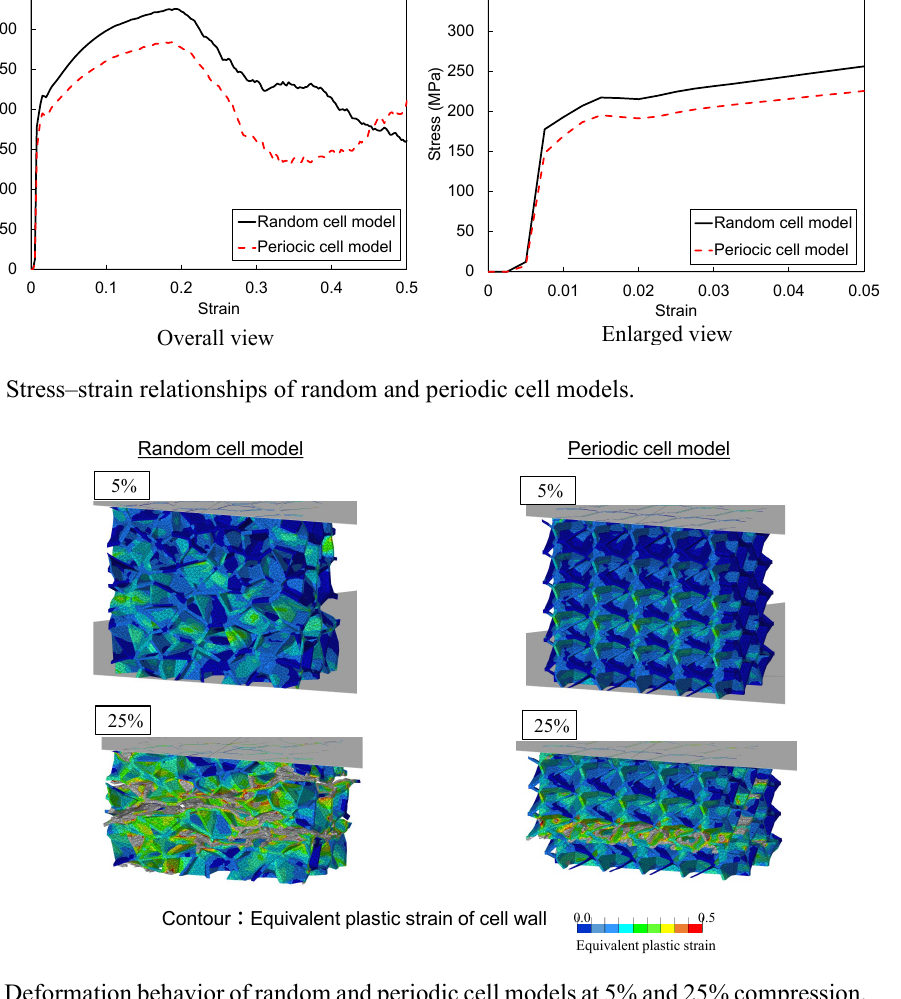
Fig.5. Deformation behavior of random and periodic cell models at 5% and 25% compression.